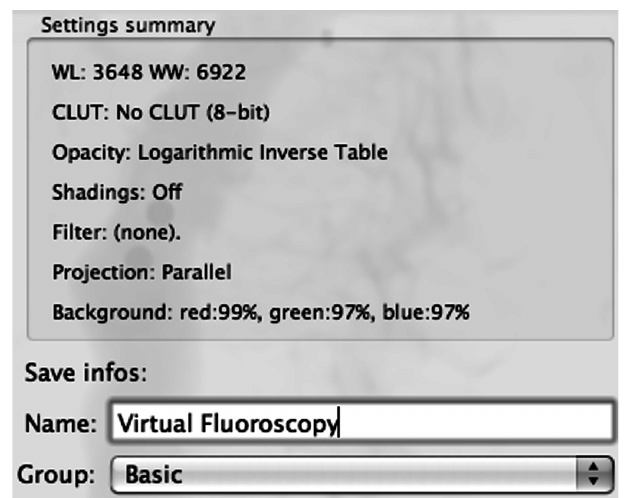
Fig. 3 - Manual configuration of the preset 3D at OsiriX MD, named as Virtual Fluoroscopy. Window width (WW - the window width) sets the number of gray scales shown and window level (WL - the window level) sets the value of the average gray scale of this width. CLUT (color look up table - lookup table of colors) defines a mechanism of the software used to transform a range of input color to another color range[5]. When represented as No-CLUT in 8-bit, it displays images in grayscale. Turning off the shading feature the effect of light is reduced (to enhance the three dimensional appearance) favoring the perception of the final image as biplanar, as it is conventional in a fluoroscopy. This configuration may be republished in any OsiriX